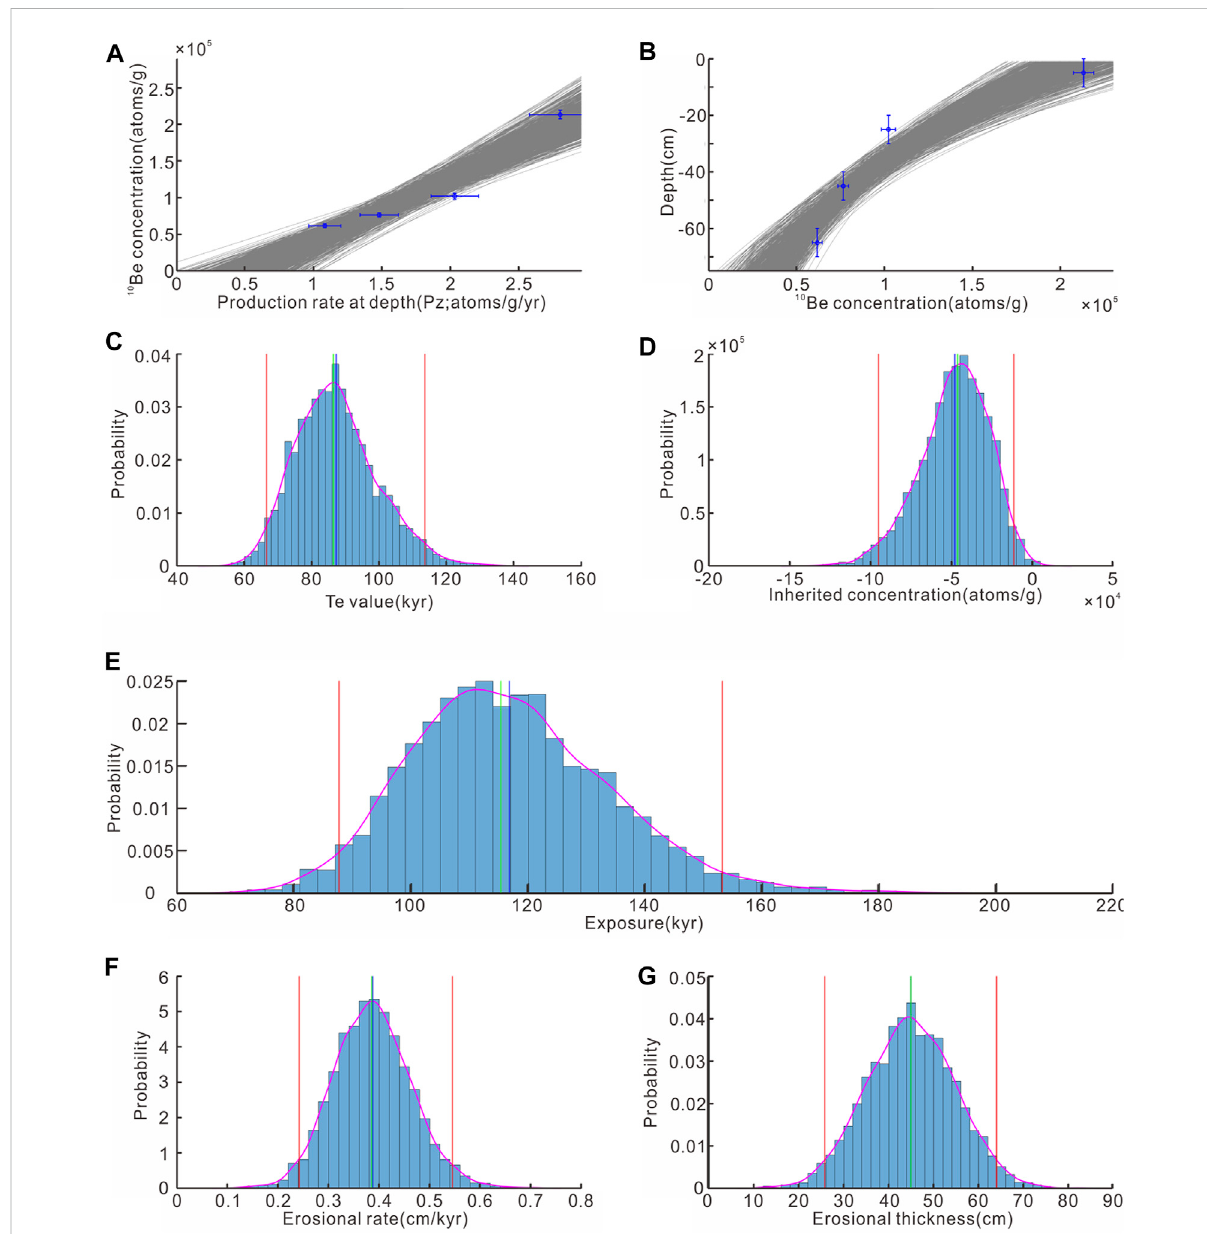
FIGURE 5 Linear regression results for the GDS data set with the eroded-thickness approach after 100,000 iterations. (A) Relationship of sample concentration to production rate at depth. (B) Distribution of the depth pro fi le models with best- fi t curves. (C) Distribution of the effective